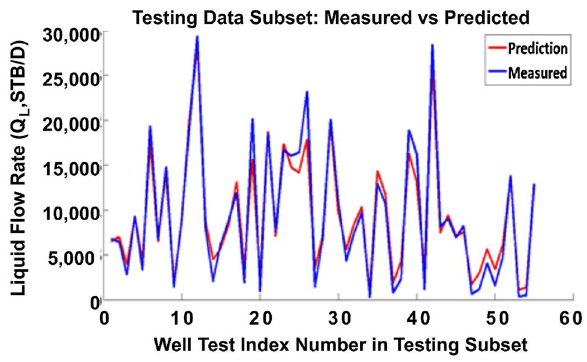
Fig. 5 Liquid flow-rate ( Q L ) prediction reliability and accuracy for the Reshadat oil field testing data subset applying the GA optimized Eq.